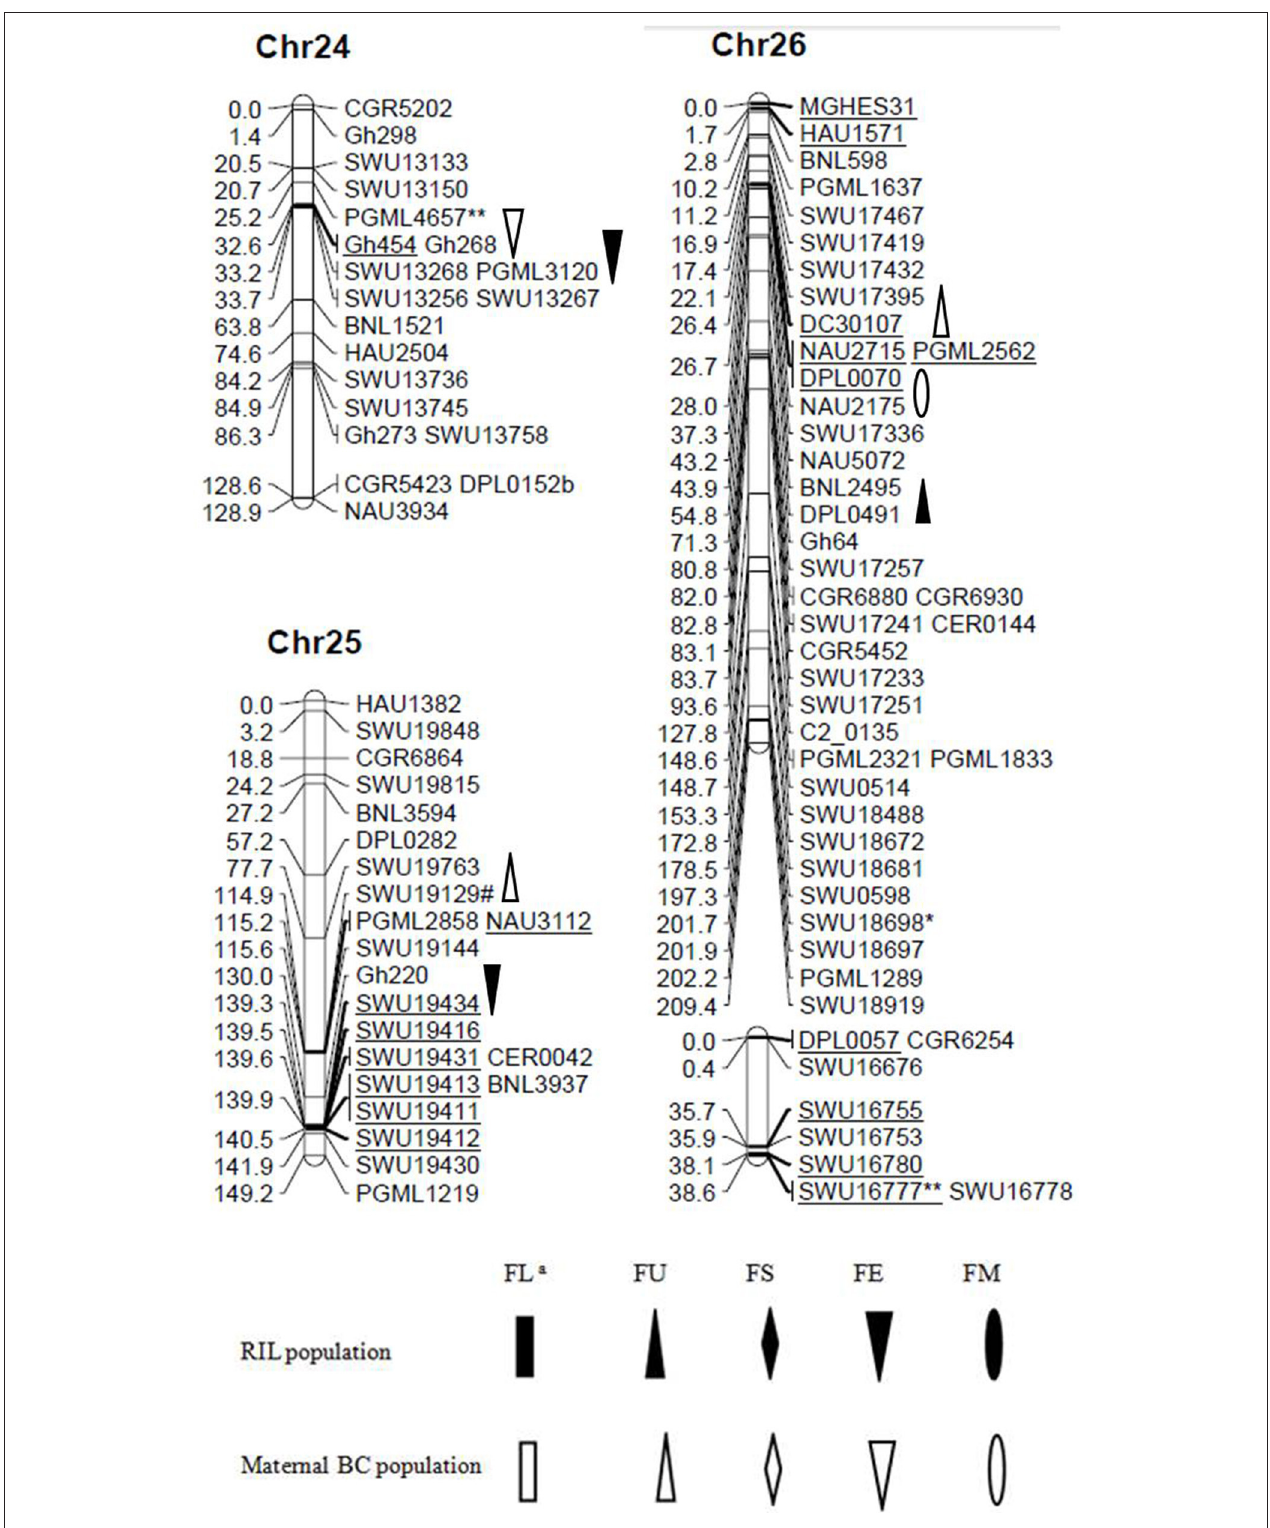
FIGURE 1 | Locations of QTLs for fiber quality traits identified in RIL and BC populations. * and ** ( # and ## ), marker showed, respectively, segregation distortion significant at P = 0.05 and 0.01 levels; markers with * and ** skewed toward the GX1135 alleles, and markers with # and ## skewed toward the GX100-2 alleles. a FL, fiber length; FU, fiber uniformity; FS, fiber strength; FE, fiber elongation; FM, Micronaire.